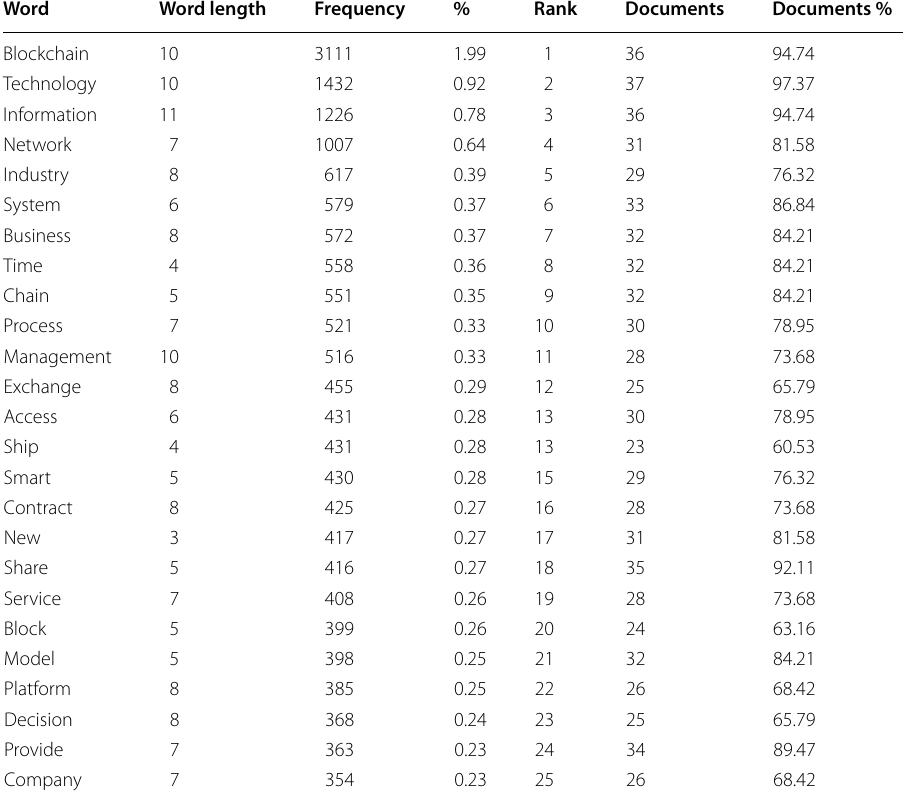
Table 1 Frequencies of top‑25 words in the text data Word Word